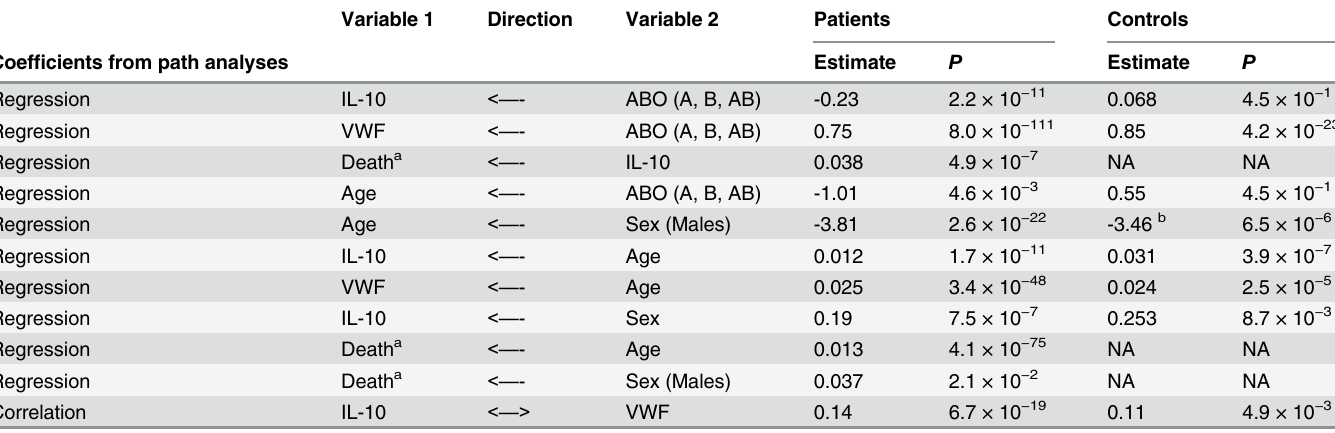
Table 8. Coefficients and direction of effects from the path analyses.